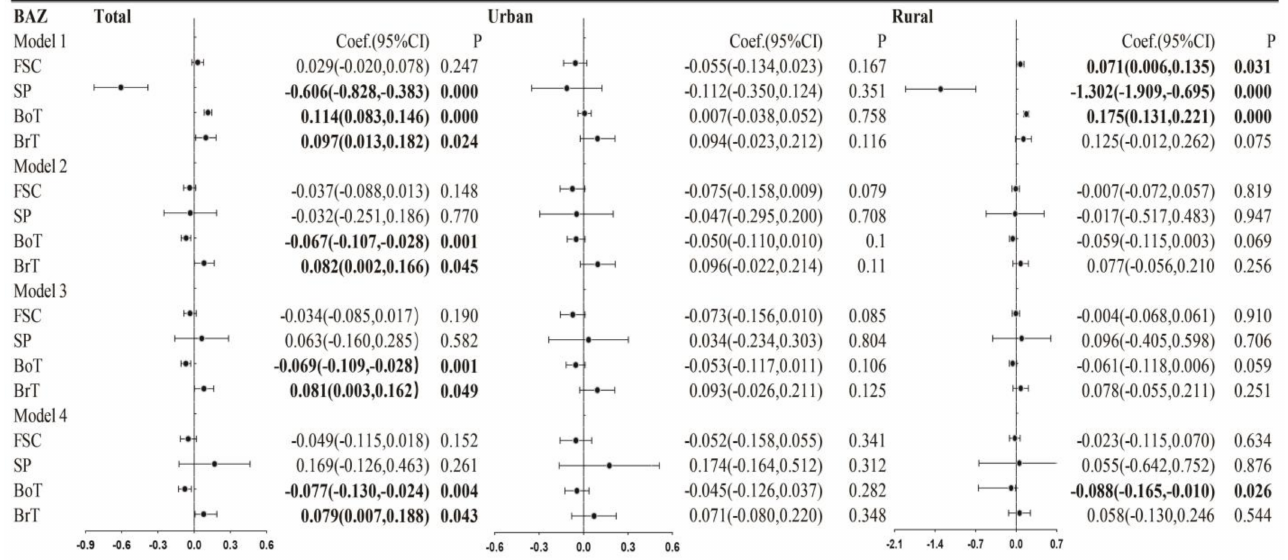
Figure 4. Longitudinal estimations of the relationships between social capital components and BAZ for the total, urban, and rural children. Note: 1. Model 1: Social capital components were separately included. Model 2: Adjusted for children’s age and gender. Social capital components were separately included. Model 3: Adjusted for children’s age and gender. Social capital components were